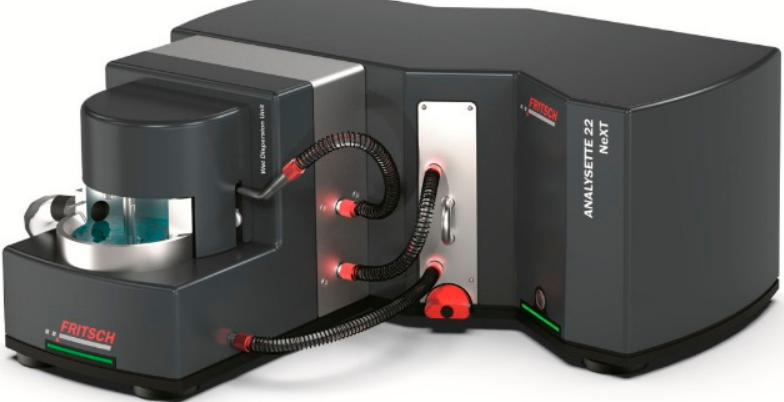
Figure 4. Laser diffraction particle size analyzer Fritsch Analysette 22.